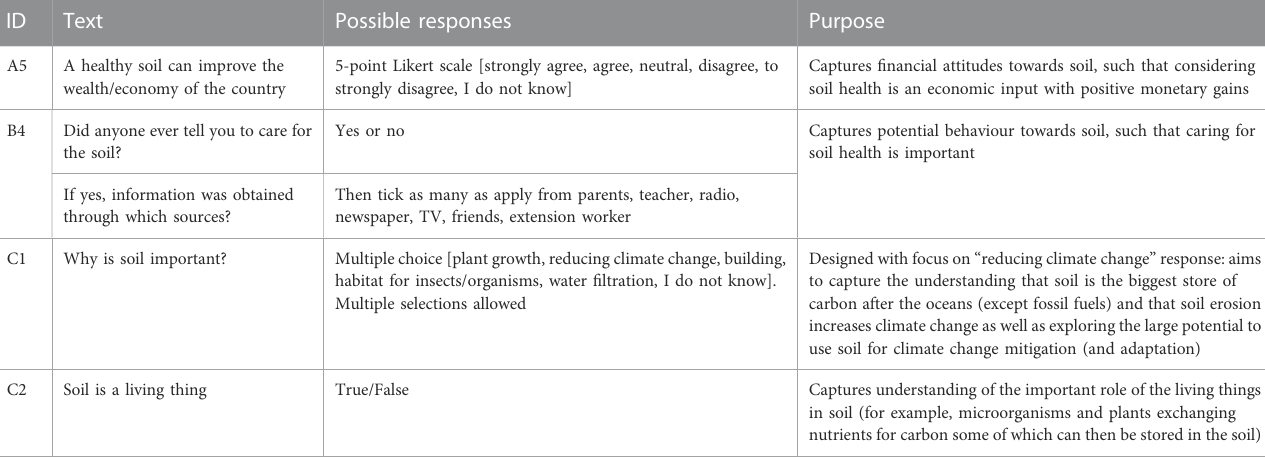
TABLE 2 Rationale behind asking selected soil attitude behaviour and competency questions.